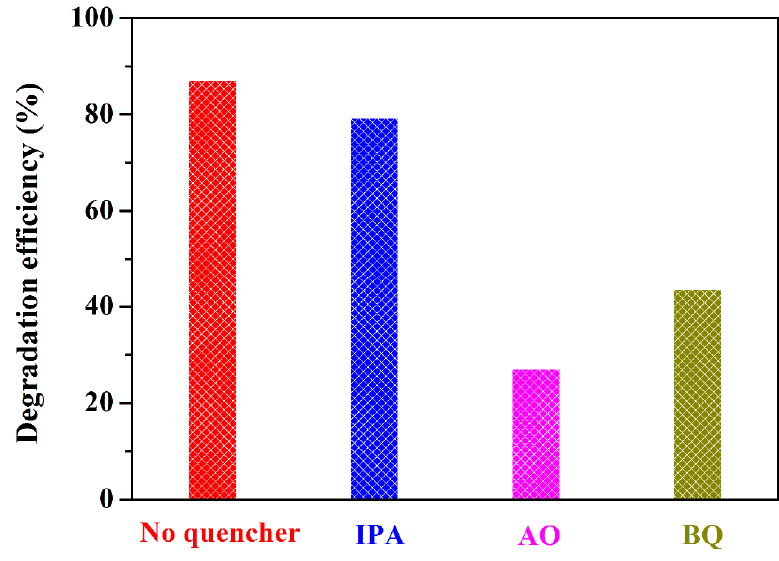
Figure 10. Influences of quenchers on the photocatalytic capability of IBOCH-2.